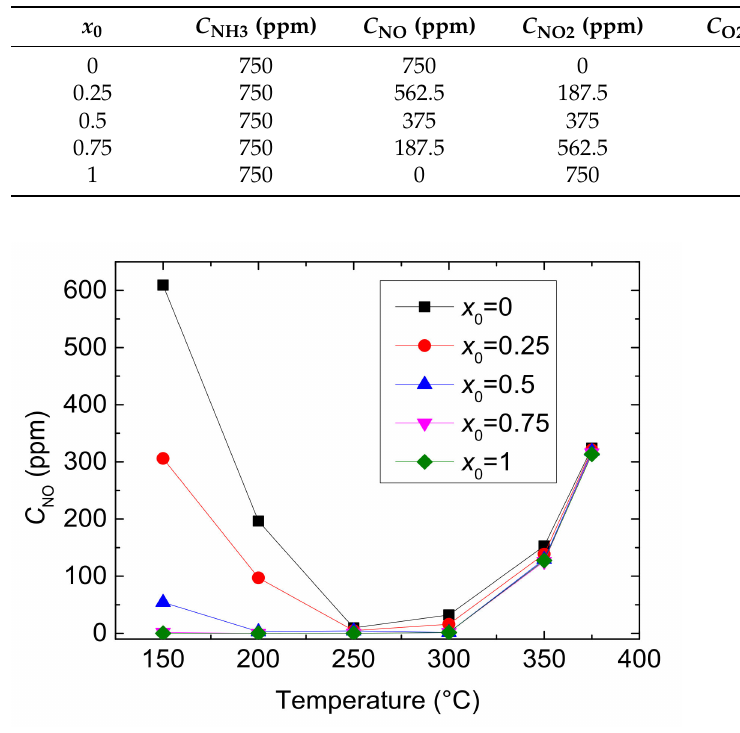
Figure 4. Outlet C NO with different values of x 0 and reaction temperatures.